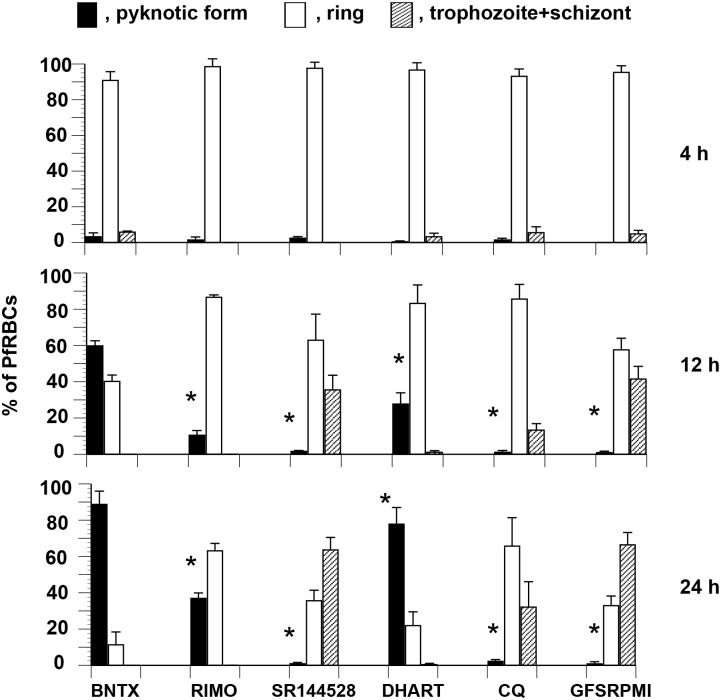
Early occurrence of pyknosis in P. falciparum cultured in the presence of BNTX, RIMO, and DHART.Parasites were characterized after 4, 12, and 24 h of synchronized culture at the ring stage. Data are presented as percentages of pyknotic form, ring form, and trophozoites + schizonts. Reagents were supplemented at concentrations of 20 μM BNTX (11.83 × IC50), 20 μM RIMO (11.43 × IC50), 20 μM SR144528 (10.81 × IC50), 50 nM DHART (9.98 × IC50), and 200 nM CQ (9.94 × IC50). Based on the dose-response curves, the IC50 values of DHART and CQ were 5.01 ± 0.11 and 20.12 ± 0.15 nM, respectively. *Significant difference versus BNTX in each culture period.